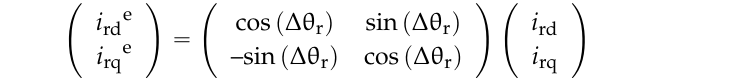
Figure 7. Block diagram of the control model of the proposed decoupled control with slip angle error.